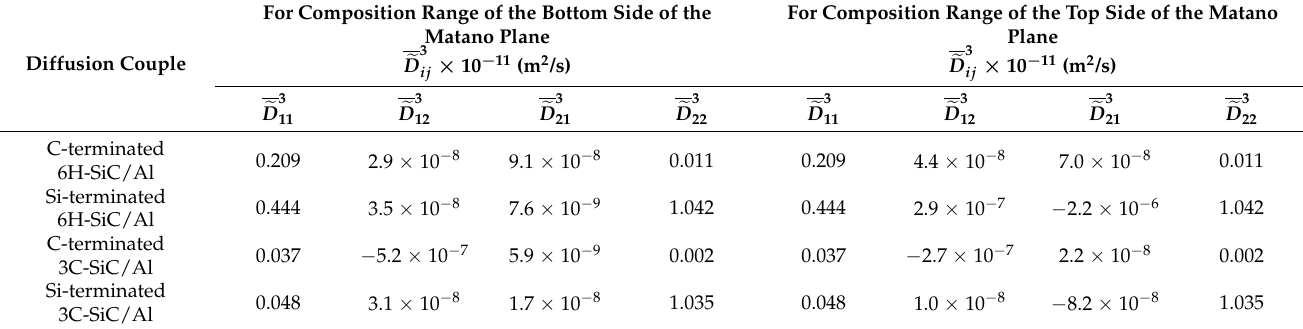
Table 4. Average values of main and cross-interdiffusion coefficients of the defect-free ternary SiC/Al systems on each side of the Matano plane after maintaining the systems at 1000 K for 6 ns (indices: 1 = Al; 2 = Si; and 3 = C).